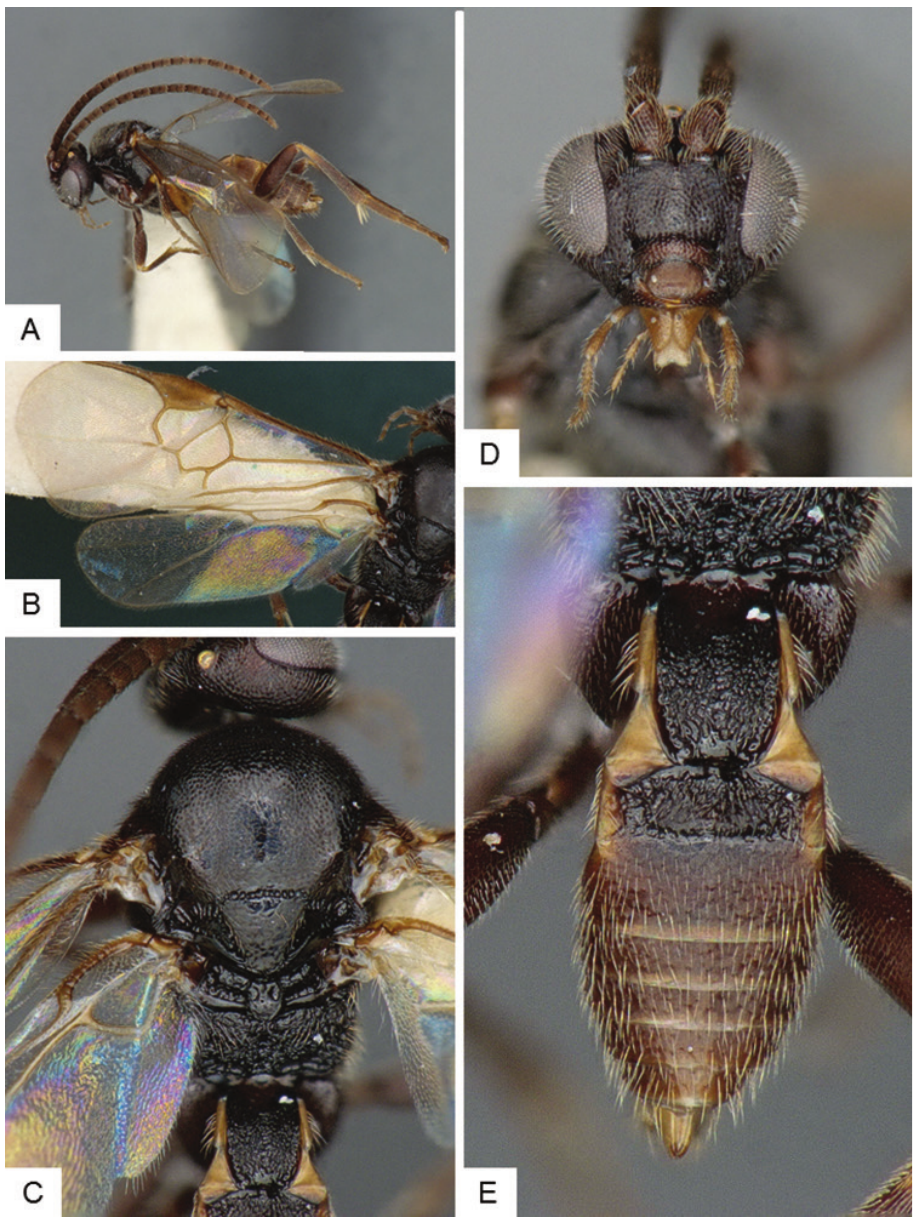
Figure 21. Illidops sp. 1. A Habitus, lateral B Fore wing and hind wing C Head and mesosoma, dorsal D Head, frontal E Metasoma,